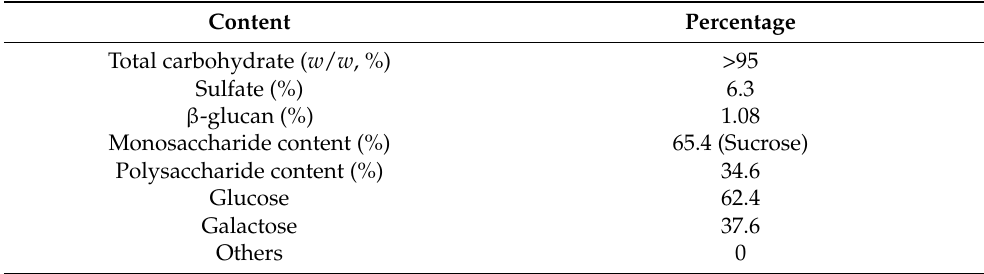
Table 3. The composition of the carbohydrate of Agaricus blazei spent substrate extracts. Content Percentage Total carbohydrate ( w / w ,